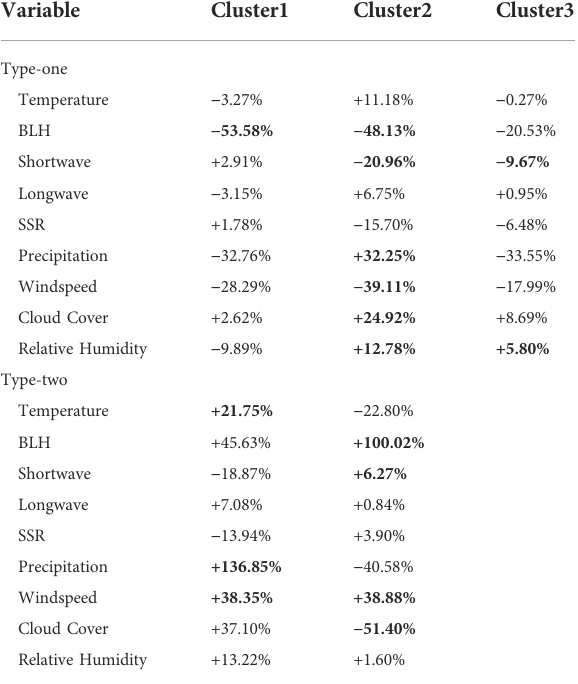
TABLE3Meteorologicalfactorpercentchangesin5clusters.Thebold font indicates an important in fl uencing factor. Units: % Data source: ERA5-1000 hPa & Surface. The relative anomalies are with respect to the average value of every hour in every month. Bold fonts indicate the main factors in fl uencing the speci fi c seesaw